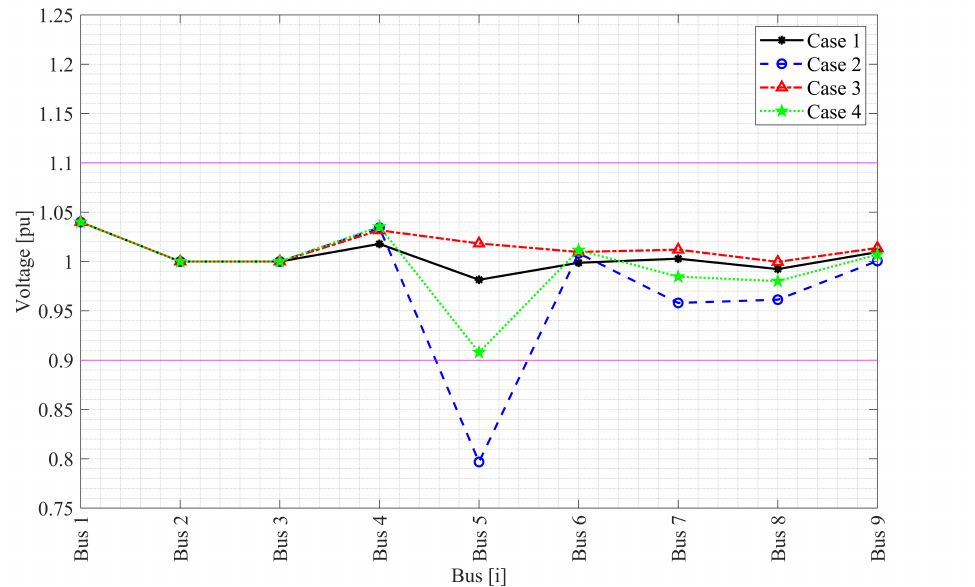
Figure 2. Nodes voltages of the 9-bus bar IEEE system.